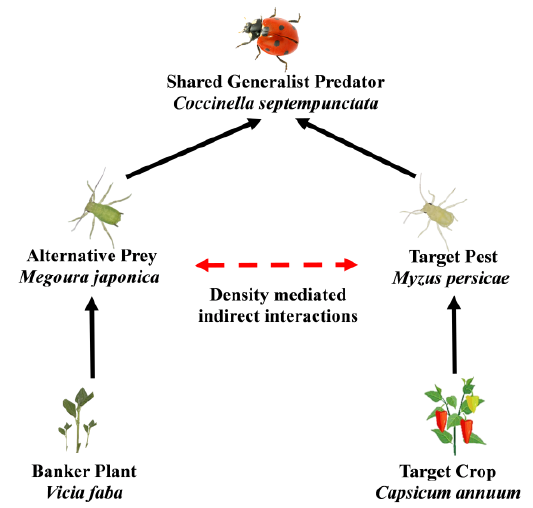
Figure 1. A schematic illustration of the indirect interactions existing between species in the Coccinella septempunctata – Megoura japonica – Vicia faba banker plant system. Solid arrows indicate the trophic relations among host plants, preys, and the predator; dotted arrows show the indirect interaction between the numbers of the alternative prey Me. japonica and the target pest Myzus persicae , mediated by the shared predator C. septempunctata